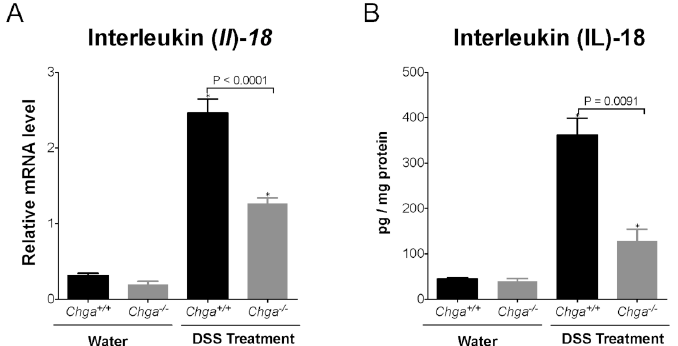
Figure 4. Deletion of chromogranin-A gene ( Chga ) reduces interleukin (IL)-8 & IL-18 mRNA expression and release in acute dextran sulphate sodium (DSS)-induced colitis. Wild-type ( Chga +/+ ) and Chga -knockout ( Chga − / − ) mice were given 5% DSS solution for five days in the drinking water to induce colitis. Control mice received water without DSS. Mice were sacrificed at day five, and whole colonic tissues were processed for mRNA expression and ELISA. ( A ) Colonic Il-18 mRNA expression quantified by RT-qPCR; ( B ) Colonic protein level of IL-18 quantified by ELISA. One-way ANOVA followed by Tukey’s multiple comparison test. Each value represents the mean ± SEM, n = 6–8 per group. * p < 0.005 refers to significance compared with water treatment groups.